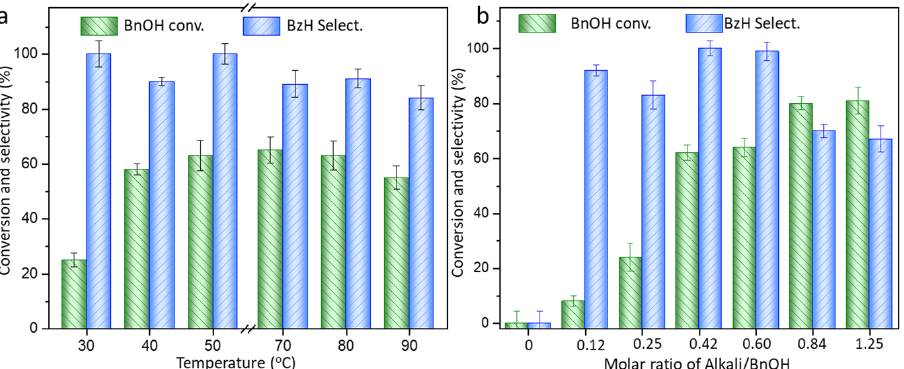
Figure 2. Catalytic performance of the AuNi 8 /CNT catalyst as a function of reaction temperature ( a ) and the alkali dosage ( b ). Reaction condition: Reaction at 50 °C for 3 h, O 2 flow rate of 40 mL/min, 10 mg catalyst, alkali/BnOH = 0.42:1, BnOH/Au = 650:1 (molar ratio), if not specified. BnOH—benzyl alcohol, BzH—benzaldehyde.